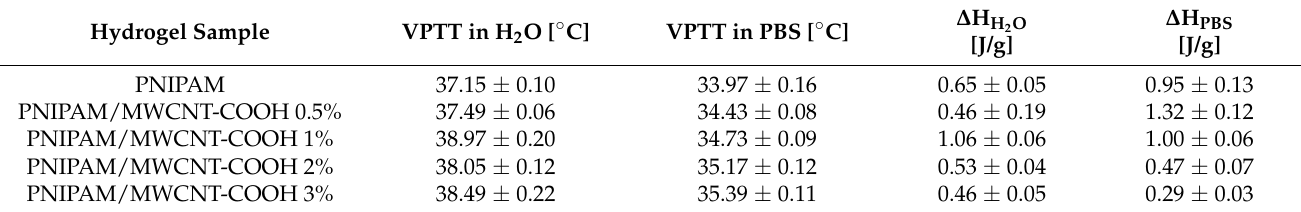
Table 2. Comparison of volume phase transition temperatures (VPTT) and related enthalpy variations ( ∆ H) of PNIPAM/MWCNT-COOH hydrogels equilibrated in pure water and in PBS solution. Hydrogel